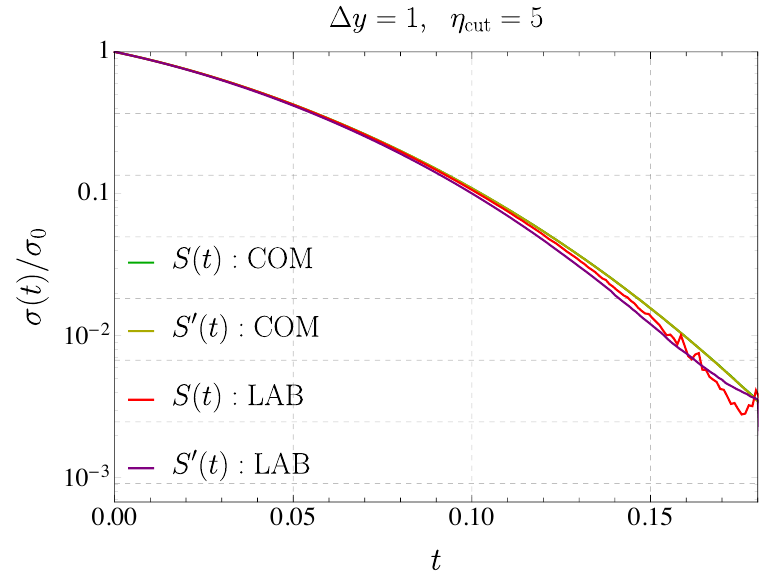
Figure 13 . Numerical comparison between di(cid:11)erent simulation algorithms and collinear regular- ization methods (lab-cone versus center-of-mass cone). The curves labelled S ( t ) are obtained from simulating the cross section, the ones labelled S 0 ( t ) are obtained after simulating the derivative and integrating. The two COM curves are completely